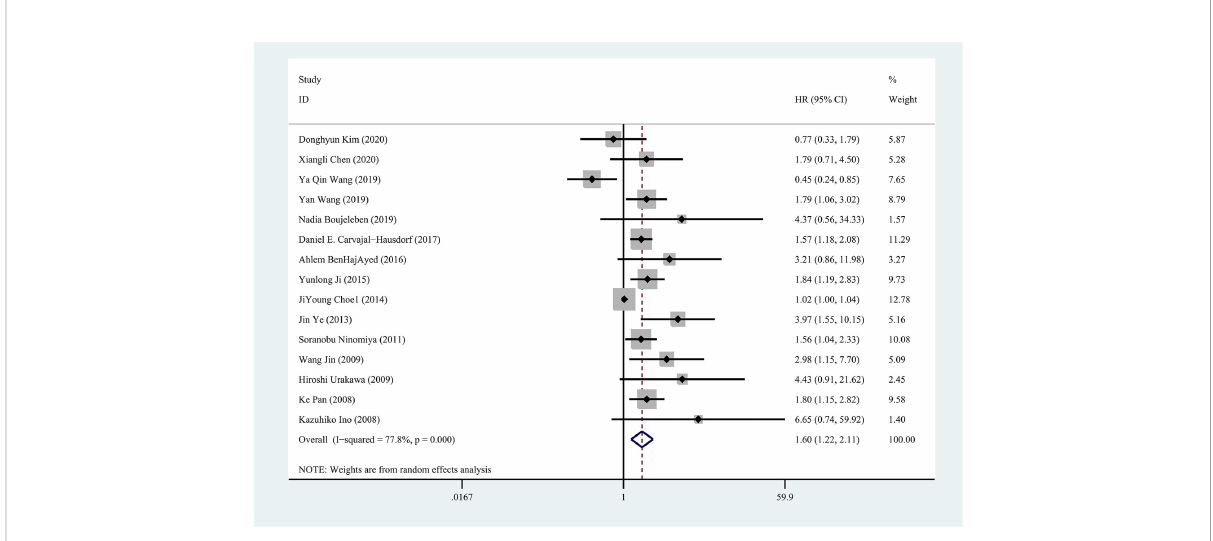
FIGURE 2 Forest plot of HR with 95% CI for correlation between expression of IDO1 and overall